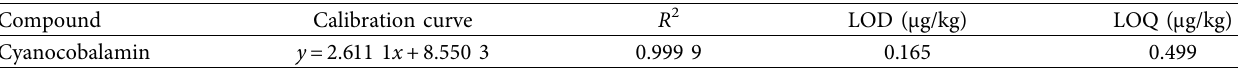
Table 3: Accuracy and precision of HPLC analysis for cyanocobalamin. Compound Medical